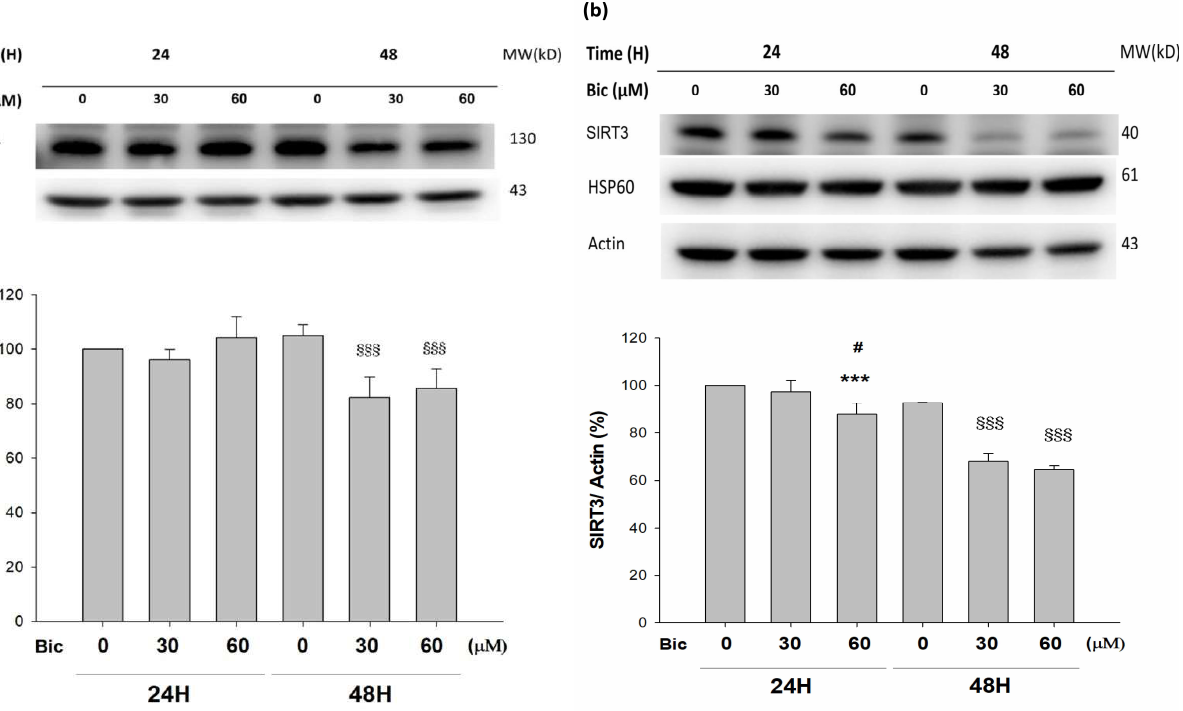
Figure 7. Representative western blot and densitometric analysis showing level of SIRT1 ( a ) and SIRT3 ( b ) proteins in RMC cells following 0, 30, and 60 µ M of bicalutamide treatment for 24 and 48 h ( β -Actin was used as normalization control). Bar graph represents the mean ± SD of triplicate experiments: *** p < 0.001 compared to Bic 0 µ M at 24 h. # p < 0.05 compared to Bic 30 µ M at 24 h. §§§ p < 0.001 compared to Bic 0 µ M at 48